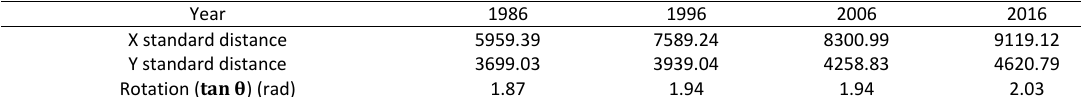
Table 6: Directional distribution results